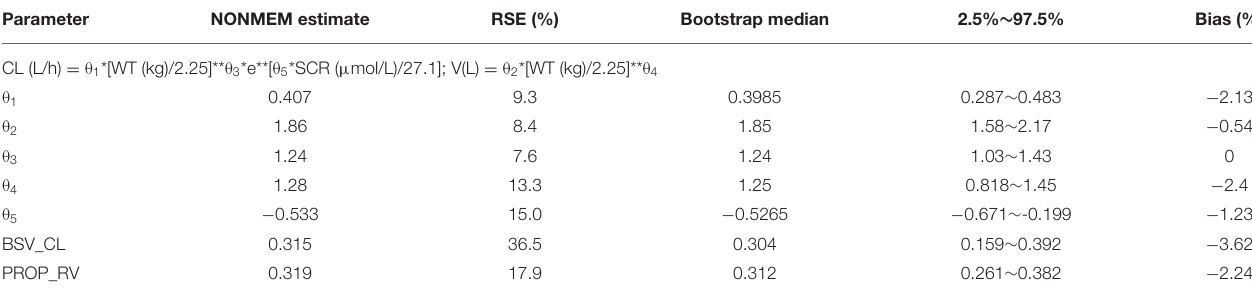
TABLE 5 | NONMEN estimates and bootstrap analysis of Model 1.